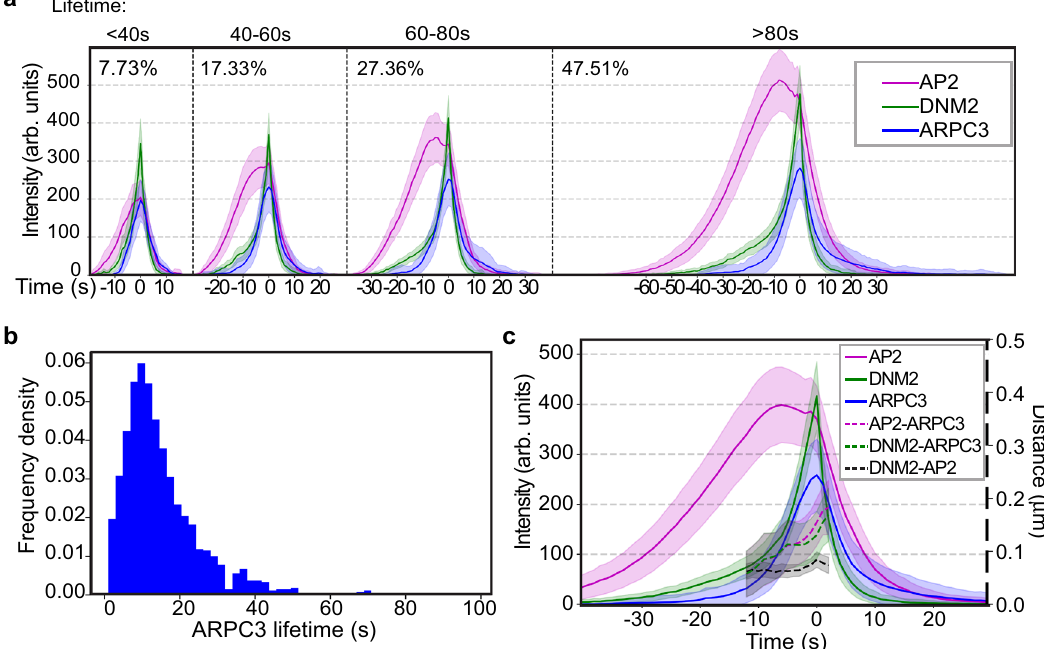
Fig. 4 Computational analysis of ARPC3 positive CME sites reveals asymmetric actin network assembly at the late stage of CME. a Averaged intensity vs time plots of cohorts of CME sites with late ARPC3 assembly in ADA cells. Events are grouped into cohorts by the lifetimes of AP2 and aligned to the frames showing the maximum DNM2 intensity (time = 0 s). Percentage of the number of the CME sites in each cohort is shown next to the plot. b Histogram of ARPC3-mediated actin network assembly duration. The assembly duration is measured from the fi rst frame of the ARPC3 signal to the presumed scission time (the peak of DNM2 signal). Source data are provided in the Source Data fi le. c Averaged intensity (solid lines) and distance (dashed lines) vs time plots of ARPC3 positive CME sites in ADA cells. Events are aligned to the frames showing the maximum DNM2 intensity (time = 0 s). Distance between centers of two signals are shown from -10 s to 3 s when DNM2 and ARPC3 signals are relatively high. a – c N = 1,385. a , c Error bar: ¼ standard deviation.